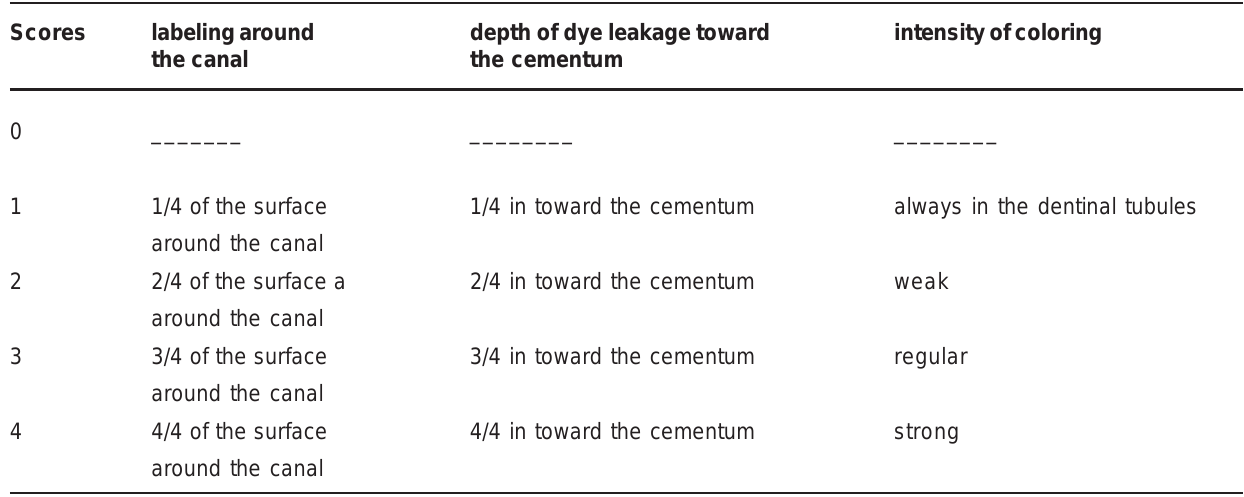
TABLE 1- Scores used in the research, taking into account factors such as quantity of labeling around the canal, depth of dye leakage toward the sealer and intensity of coloring